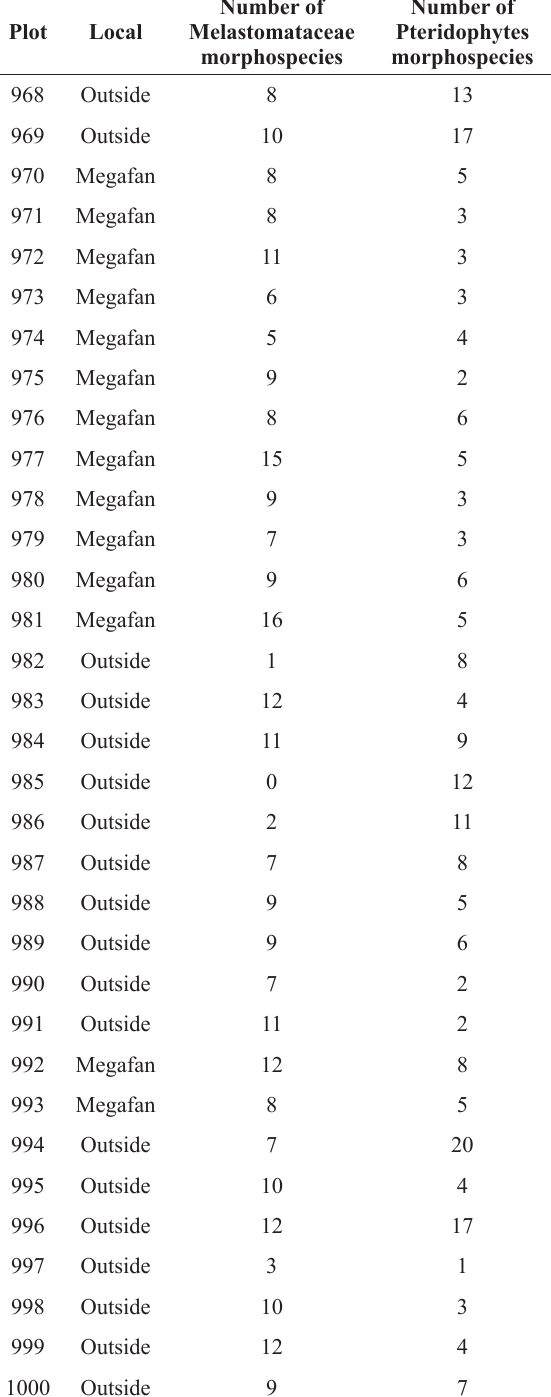
Overview of the data and number of morphospecies of pteridophytes and Melastomataceae found in each plot. The location in megafan sediments and basement rocks (Ouside) is indicated for all